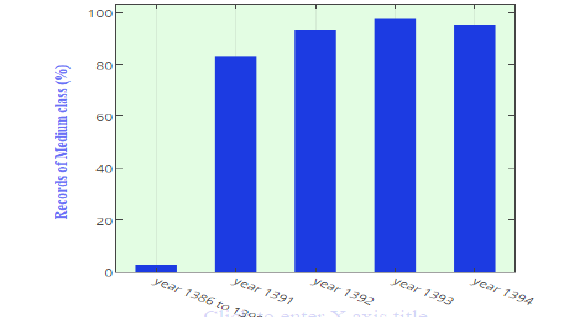
Figure 12. Melat Bank